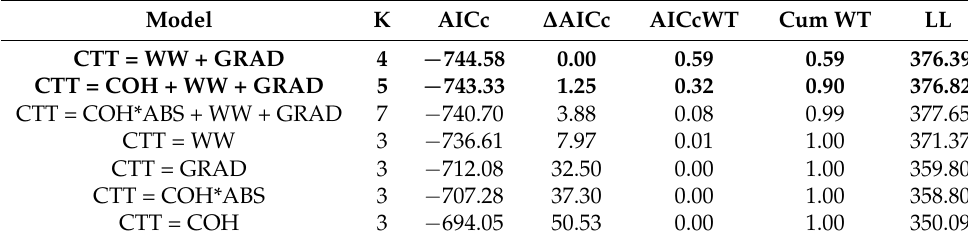
Figure 2. The probability that two species exhibit a positive or negative association within with less than 9% steam gradients. Within each cell the number of observations (OBS) and the number of expected (EXP) occurrences in these streams is indicated. Species codes are as follows: SCP = sculpin, COH = coho salmon, CTT = coastal cutthroat trout, STH = steelhead, P_lt = the probability that two species would be present at a frequency less than expected if the two species were distributed randomly, P_gt = the probability of two species co-occurring at a frequency greater than expected if the two species were distributed randomly. Table 2. Results of applying model selection to evaluate alternative models of factors influencing coastal cutthroat trout densities in watersheds in SNF and the OESF in watersheds with less than 9% steam gradients. Models within 2 ∆ AIC units of the top-ranked model have substantial support and are in bold. CTT = coastal cutthroat trout density (fpm2), COH = coho salmon density (fpm2), WW = wetted width (m), GRAD = stream gradient (percent), ABS = Average body size of coastal cutthroat trout (fork length,